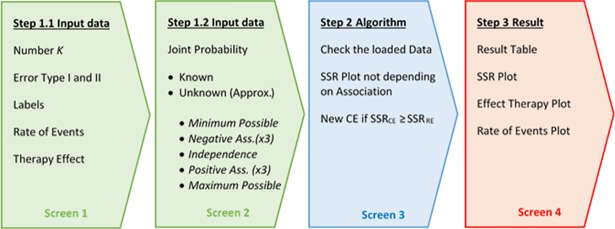
Bin-CE workflow.